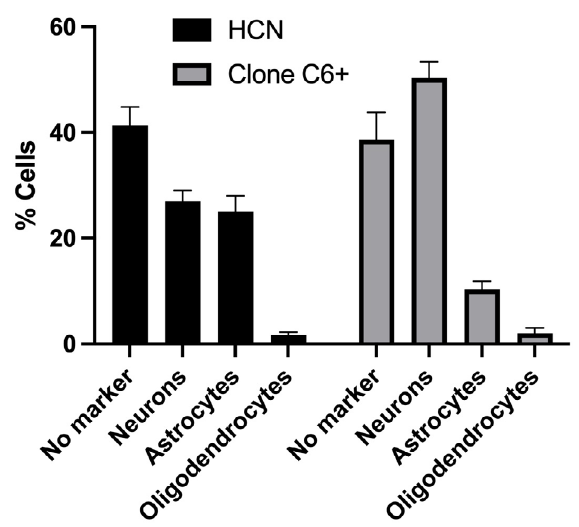
Figure 2 - Neural differentiation for the clone C6+. After a mixed differentiation protocol using retinoic acid and serum (see Supplementary Material file Methods), cells were stained and quantified for neuronal (Map2ab), astrocytes (GFAP), or oligodendrocytes (RIP) markers. These experiments were performed in triplicates (n=3) and the bars represent standard deviation.